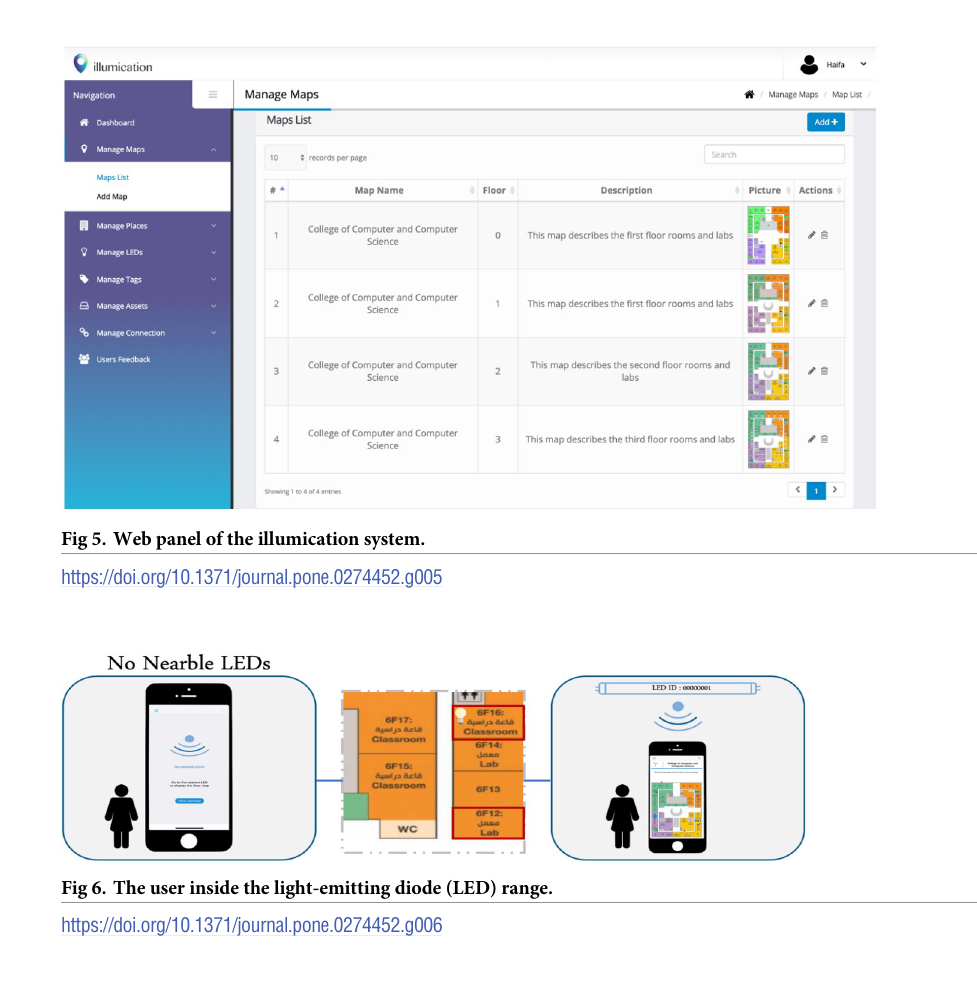
Fig 7. Mobile application of the illumication system.